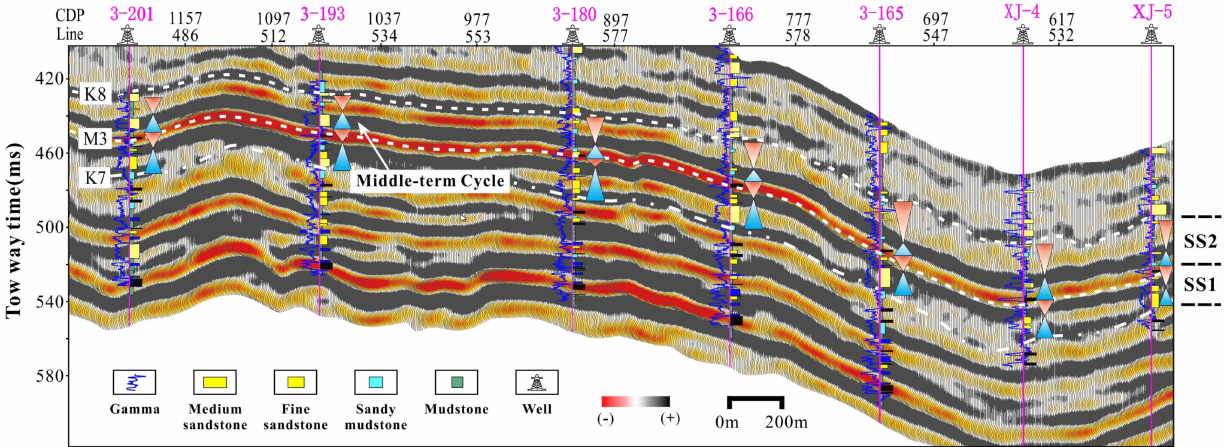
Figure 5. Seismic–geological isochronous stratigraphic frame. The Shanxi Formation was divided into two 4th-order sequences, SS1 and